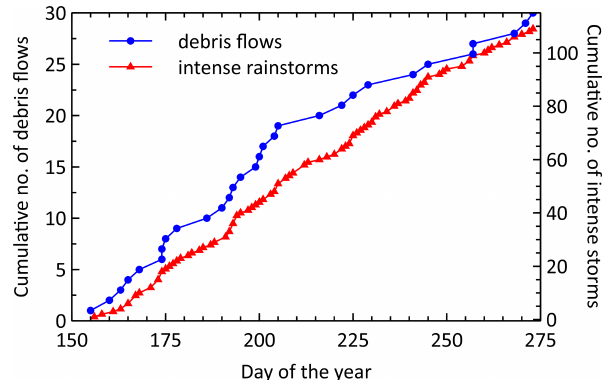
Figure 4. Day of occurrence versus cumulative number of debris flows and intense (potentially triggering) rainstorms in the observa- tion